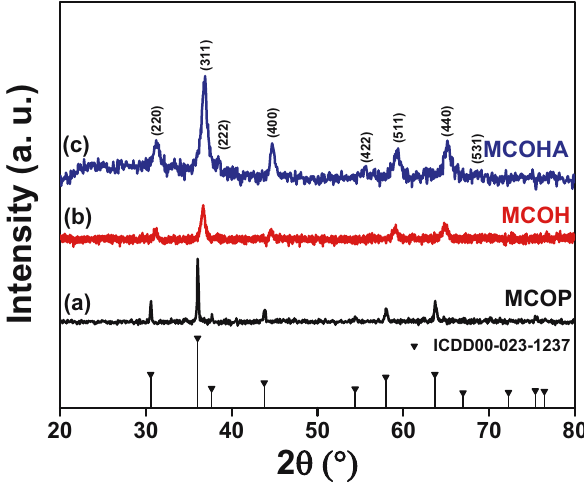
Figure 3: XRD patterns of the MCO synthetized by ( a ) Pechini method at 900°C, ( b ) hydrothermal methos with NaOH at 500°C, and ( c ) hydrothermal method with acetates at